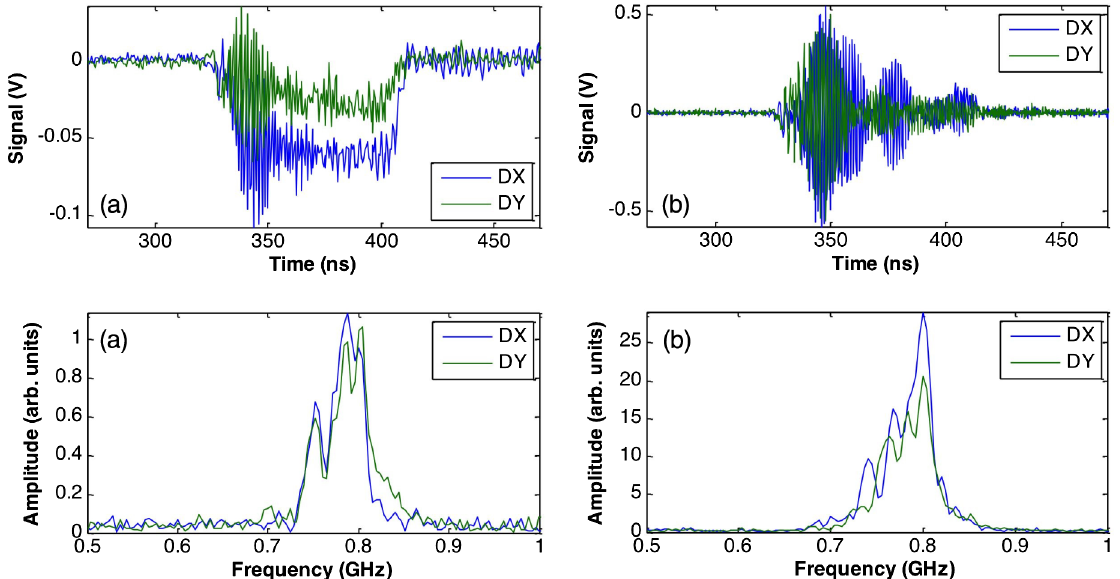
FIG. 11. Top row: Comparison of the measured (a) hardware integrated BPM signal and (b) the raw unintegrated BPM signal at BPM19 ( z ¼ 34 . 3 m). Bottom row: Fast Fourier transform of the signals above to indicate the amplitude and frequency of the BBU on the beam (note scale differences).